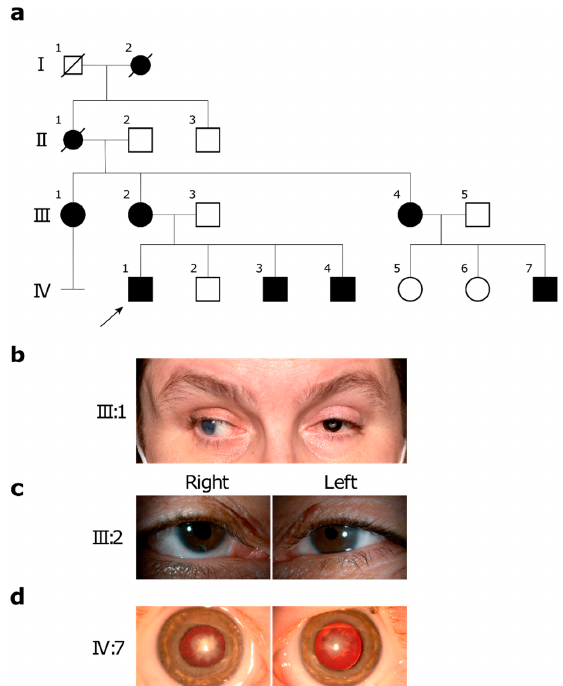
Figure 1. Pedigree and clinical images of family 1 identified as heterozygous for missense mutation EPHA2 c.1751C>T, (p.Pro584Leu). ( a ) Pedigree of family 1 with bilateral microphthalmia and congenital cataracts. The proband is indicated with an arrow. Solid symbols indicate affected individuals and blank symbols indicate unaffected individuals. Women are represented by circles. Men are represented by squares. Deceased family members are indicated by a slash. ( b ) Clinical image of microphthalmia in patient III:1, age 47, following multiple needling and lens aspiration procedures in childhood, leaving her bilateral aphakic, followed by multiple ocular surgeries including endothelial keratoplasty and cyclodiode with right amblyopia, corneal decompensation, and secondary exotropia with hand movements vision, and a left keratoprosthesis and baerveldt tube with best corrected visual acuity (BCVA) of 0.9 LogMAR in the left eye. ( c ) Clinical image of microphthalmia in patient III:2, age 44, following similar needling and lens aspiration in childhood, followed by multiple ocular surgeries for aphakic glaucoma and right exotropia; the BCVA in the right eye was 1.10, and the left eye was 1.00 LogMAR. ( d ) Clinical image of bilateral irregular nuclear and cortical cataracts in patient IV:7 age